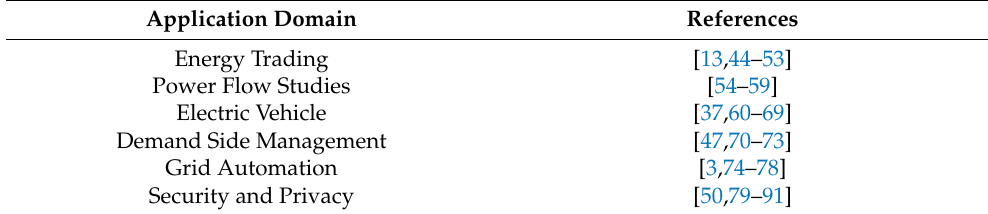
Figure 6. Application of Blockchain technology in electrical power system. Table 1. Categorization of reviewed articles on different application domains in power systems.